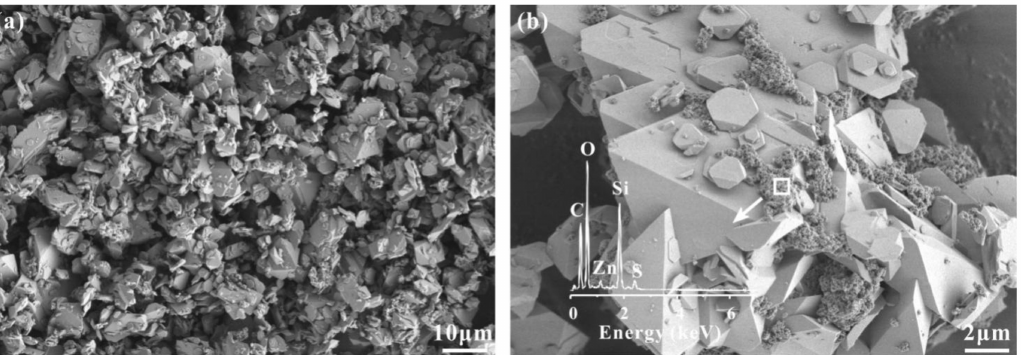
Figure 7. ( a ) SEM images of raw jarosite residues; ( b ) A higher magnification SEM image of raw jarosite residues and the EDS for elements within the white box.